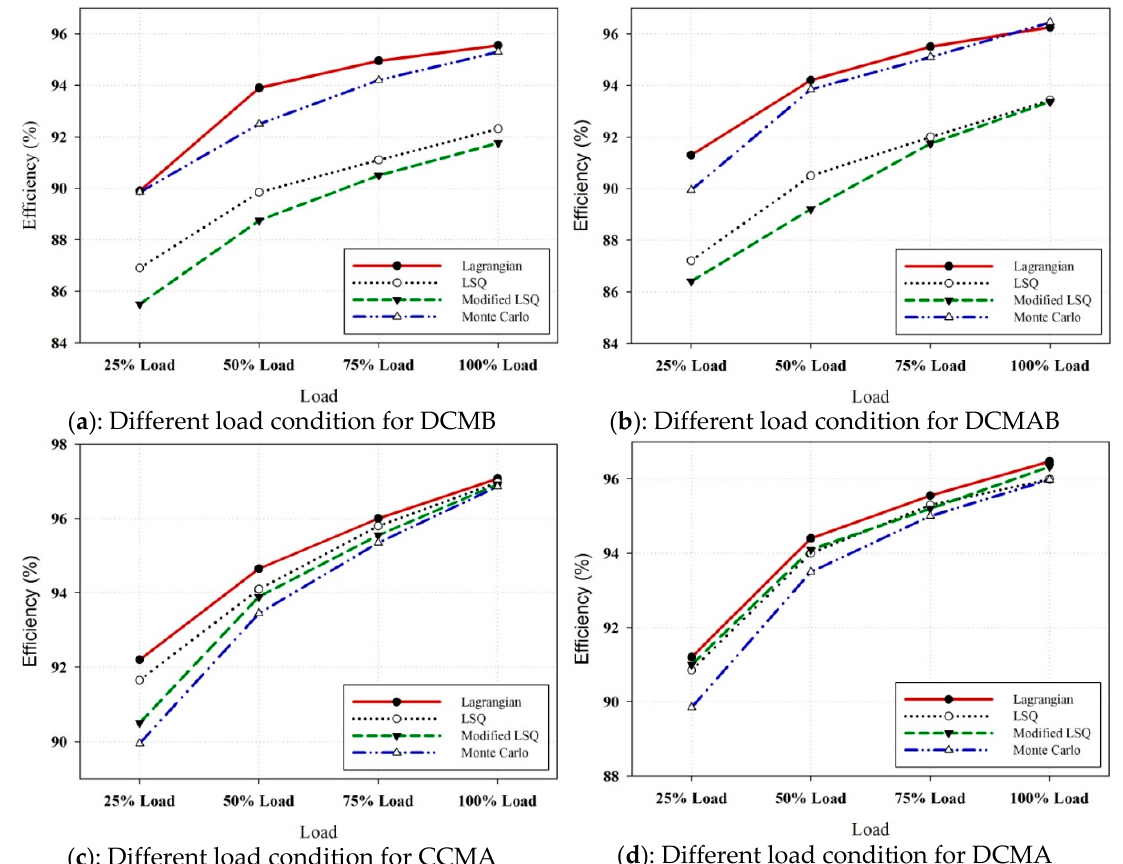
Figure 5. The efficiency at different load conditions.